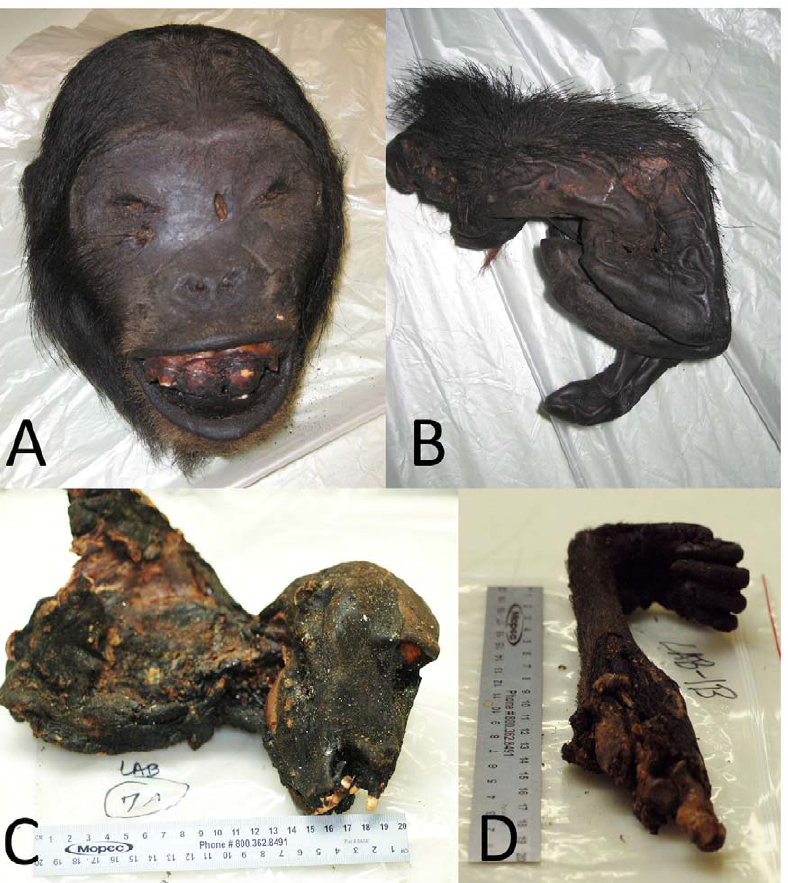
Figure 1. Nonhuman primate bushmeat specimens confiscated at US airports. Examples of smuggled simian bushmeat (a) skull, (b) hand, (c) skull and torso, and (d) arm. Ruler units are centimeters.